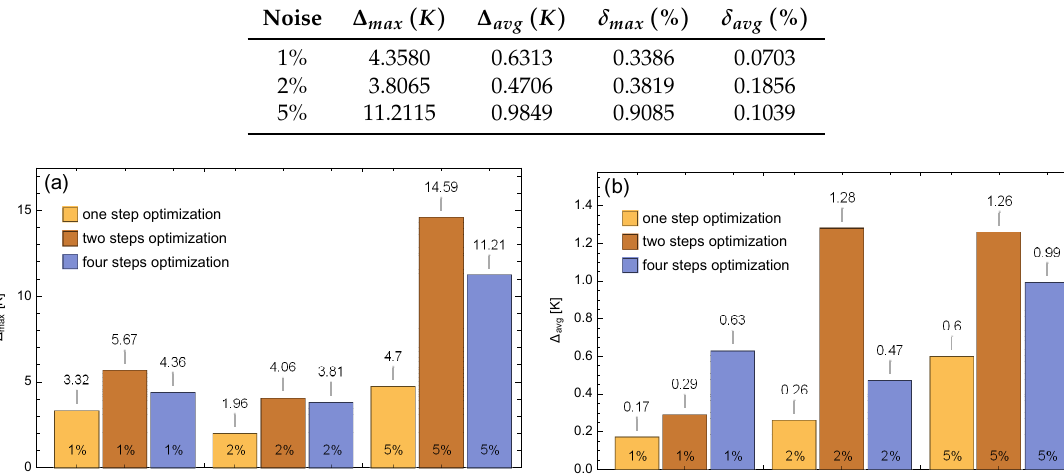
Figure 11. Comparison of ( a ) maximum and ( b ) mean relative errors of temperature reconstruction in the control points obtained in three variants of